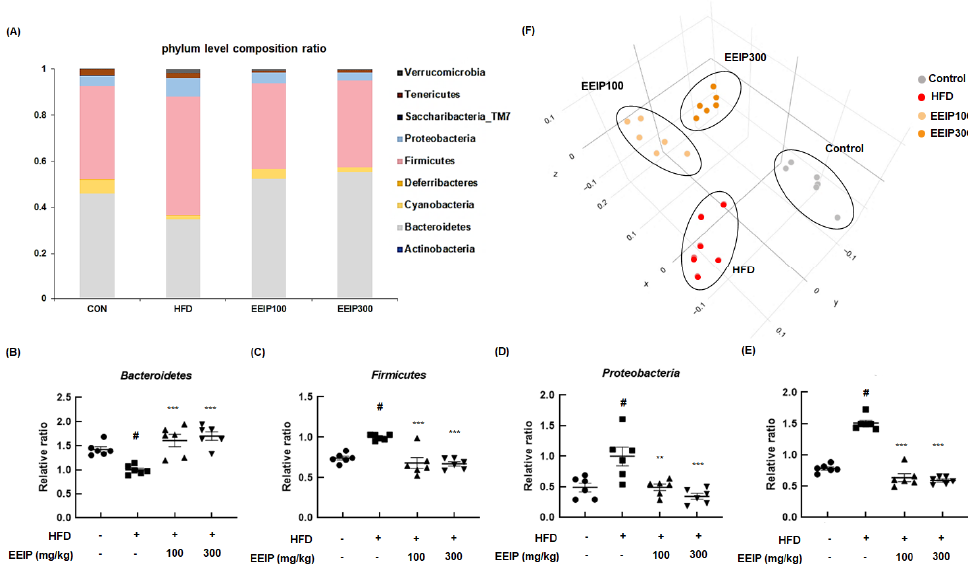
Figure 9. Effect of EEIP pre − administration on gut dysbiosis in HFD − fed obese mice ( A ) phyla level composition ratio ( F ) PCoA graph showing β diversity between groups. ( B ) Bacteriodetes , ( C ) Firmicutes , ( D ) Proteobacteria, and ( E ) Firmicutes / Bacteriodetes level quantifying graph. Values are represented as the mean ± SEM. # p < 0.05 vs. normal diet control group; ** p < 0.01, and *** p < 0.001 vs. HFD group.